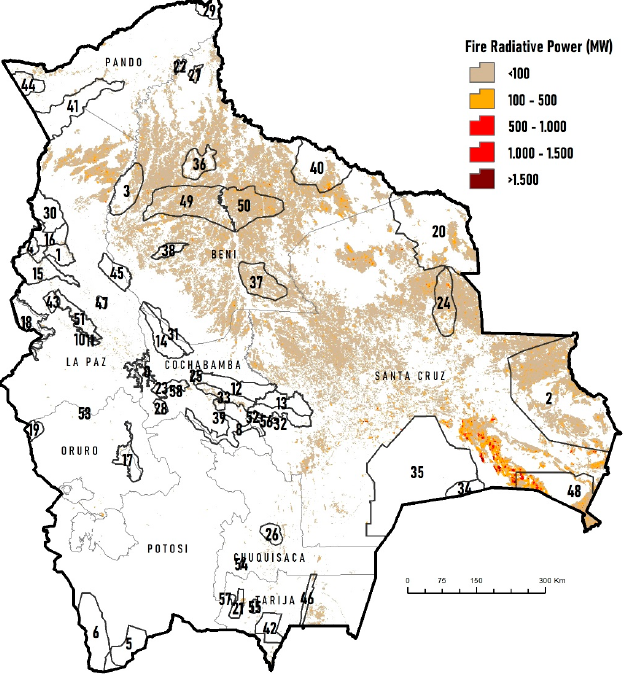
Figure 10. Intensity of wildfires in the KBA of Bolivia for the period 2001–2020, based on the interpolation of the Radiative Power of Fire (Megawatts) based on the MODIS Collection 6.1 product.